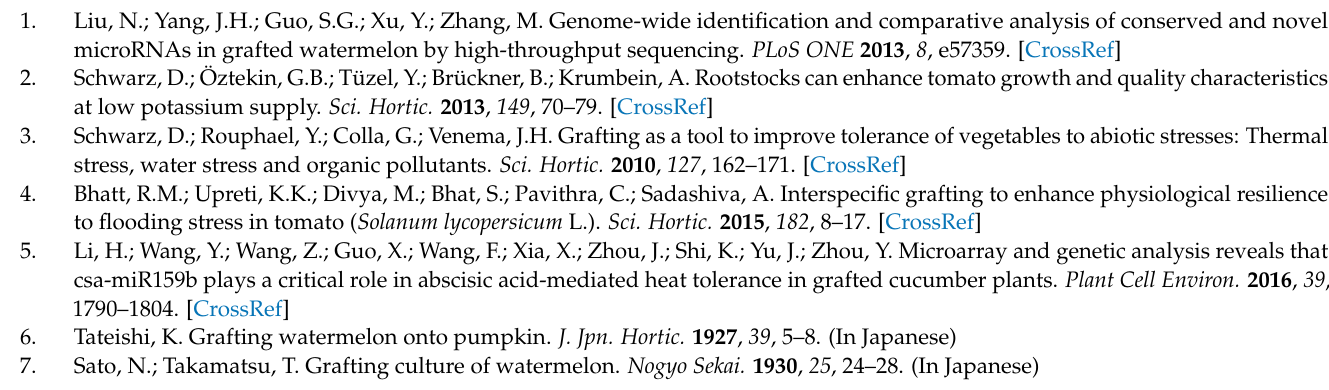
Figure S2. Expression of CIPK, CBL and PHT genes in transgenic and wild type Arabidopsis. Figure S3. PCR confirmation of ClmiR86 transformation in candidate transgenic Arabidopsis. Table S1. Formula of Hoagland nutrient solution. Table S2. Formula of full-strength MS medium. Table S3. Primers used for vector construction and confirmation of Arabidopsis transformation. Table S4. Gene-specific primers for